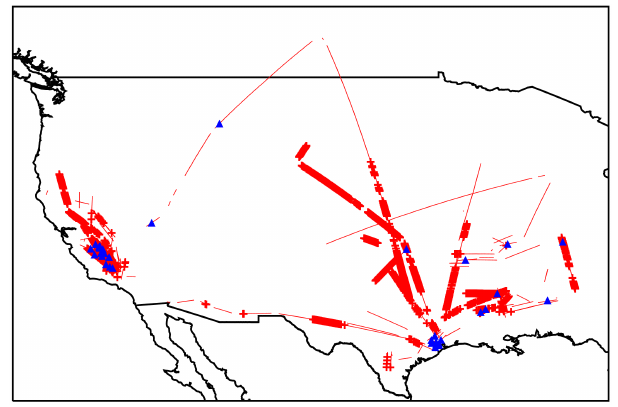
Figure 10. Map of the RSP data used in this study. The red thin lines indicate RSP flights, the red crosses indicate the availability of CPL data and the blue triangles indicate the locations of the AERONET